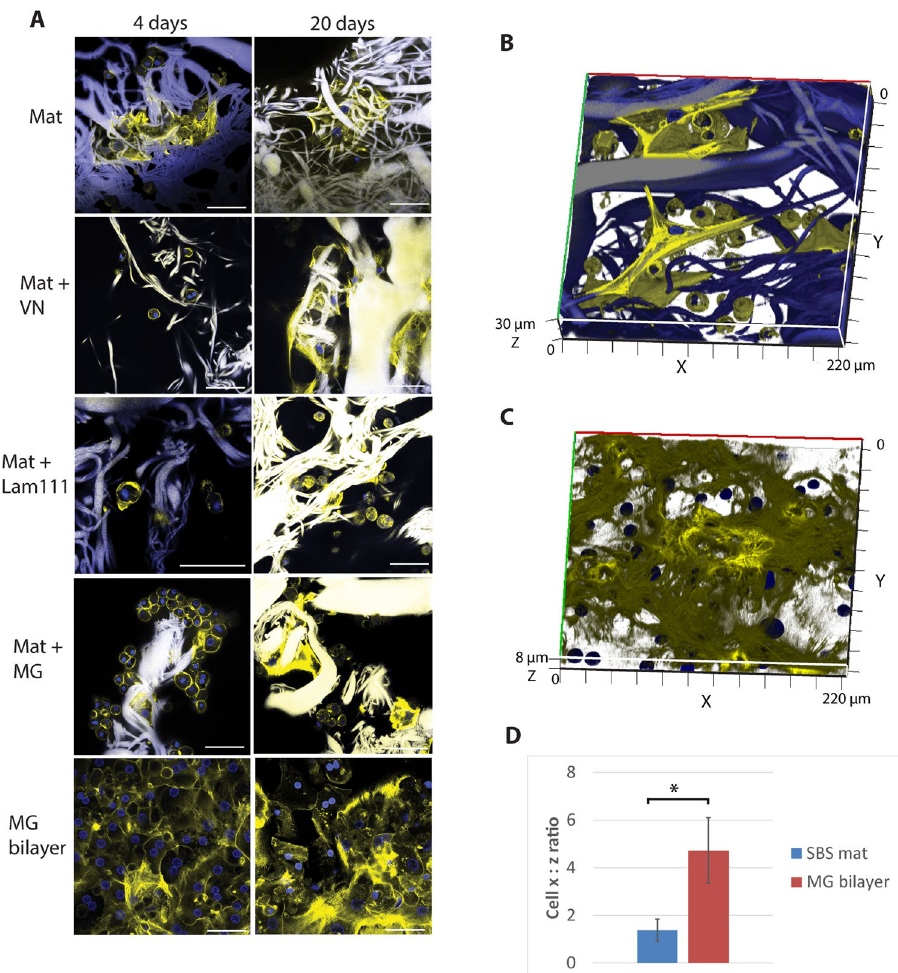
Figure 3. ( A ) Hepatocytes grown on SBS mats or in MG bilayer for 4 days (left panels) or 20 days (right panels). Scale bars 50 µm. 3D reconstruction of hepatocytes grown on mats ( B ) and MG bilayer ( C ) after 4 days of culture. Actin cytoskeleton of cells was visualized by phalloidin staining (yellow), cell nuclei were stained with DAPI (blue). The gelatin fibers appear as yellow or blue streaks due autofluorescence. ( D ) Quantification of cell shape using the cell length (x) to depth (z) ratio (x:z ratio). Summarized results from 3 independent hepatocyte culture replicates are presented, * indicates a statistically significant (P < 0.05) difference. Primary hepatocytes were cultured in serum-free hepatocyte defined growth